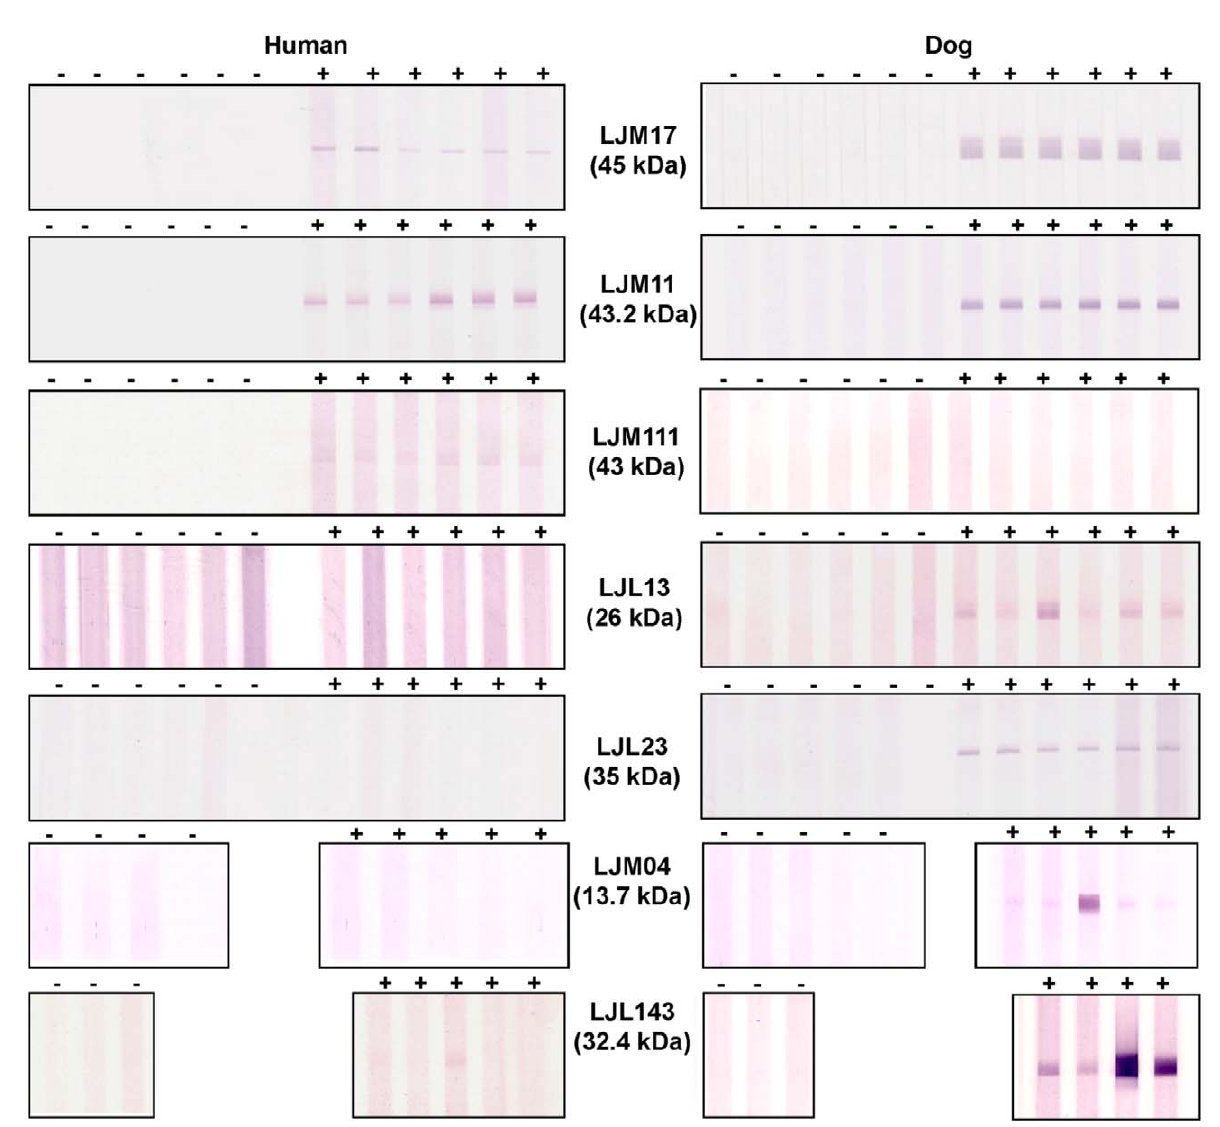
Figure 5. Detection of Lutzomyialongipalpis recombinant salivary proteins by human and dog sera from visceral leishmaniasis endemic areas. Human and dog sera from Sa ˜ o Luis and Teresina respectively, were used to screen recombinant salivary proteins LJM17, LJM11, LJM111, LJL13, LJL23, LJM04, and LJL143 by Western Blot ( + ). Human and dog sera from a non-endemic area were used as negative controls